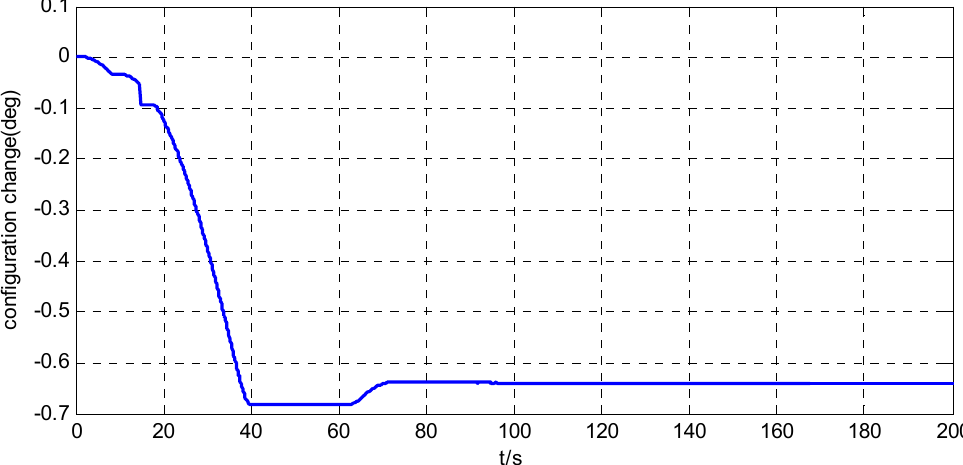
Figure 16. Relative angle error inside the simulator when x ( 0 ) =